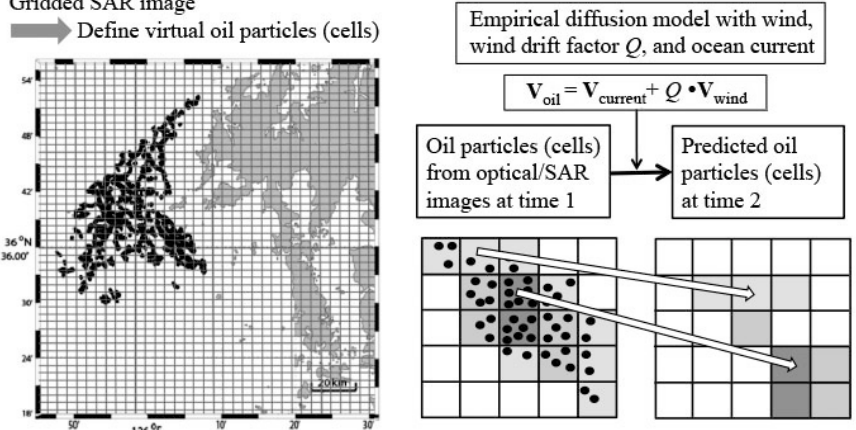
Figure 19. Prediction of oil movement, where V oil , V current , and V wind are the velocity vectors of oil, current and wind, respectively. Q is the wind drift factor.